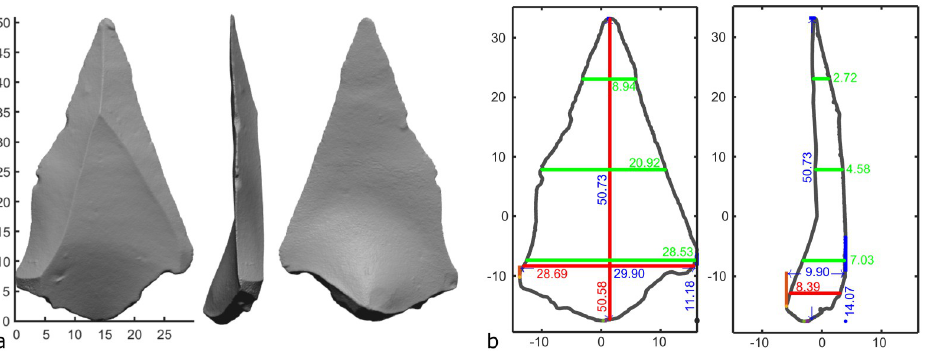
Fig 2. An example of the images produced during the Process Directory and Process Object function, showing the 3D scan in different orthogonal projections (a), as well as the key linear measurements (in mm) taken on the object (b).